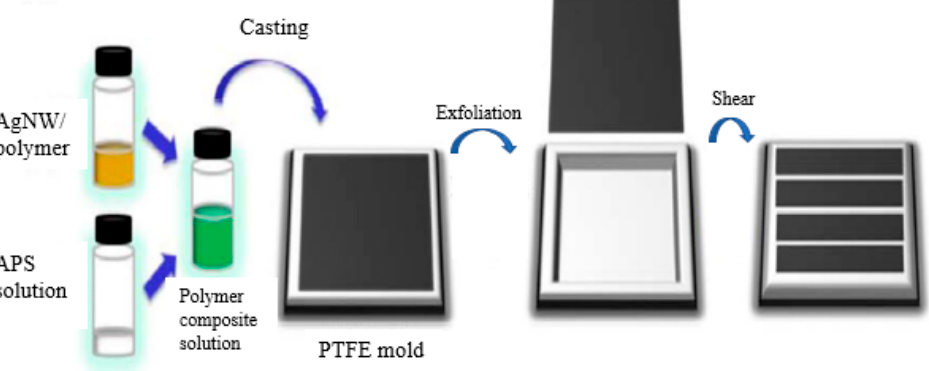
Figure 12. Schematic illustration of the steps in AgNW/polymer composite sensor fabrication. Re- printed with permission from Ref. [103]. Copyright 2020, Springer.